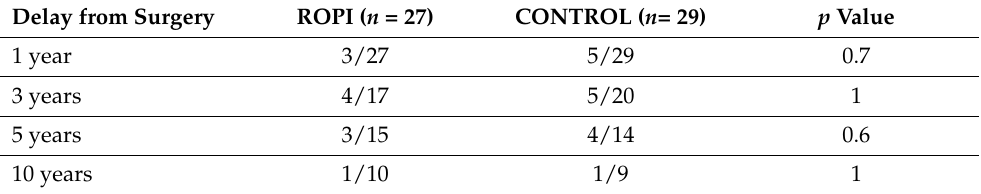
Table 2. Chronic pain patients requiring medication (number of patients/number of patients assessed). Delay from